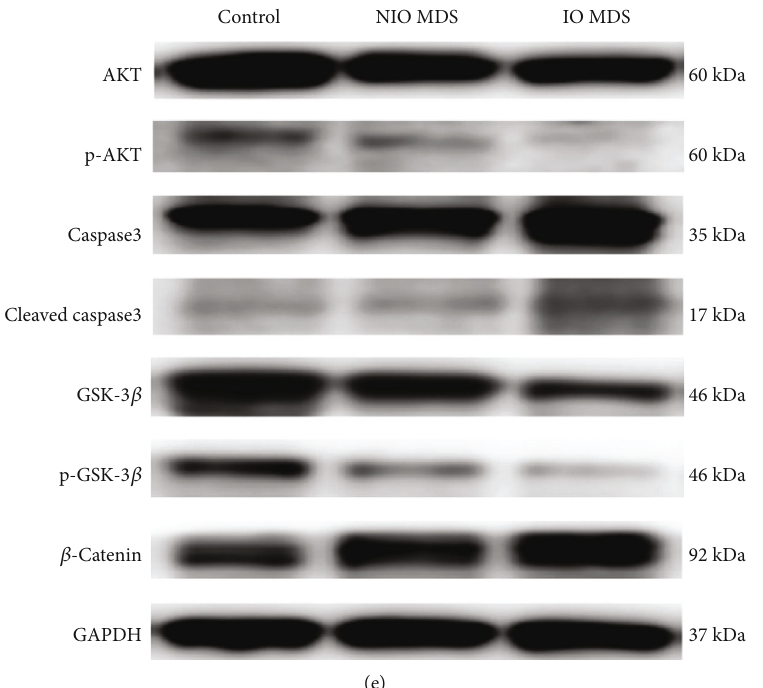
Figure 2: The mechanisms involved in IO damaging MSCs of MDS patients. (a) Compared with the NIO MDS group and the control group, the apoptosis of MSCs signi fi cantly increased in the IO MDS group ( p < 0 : 01 ). (b) Compared with the other groups, the level of ROS signi fi cantly increased in MSCs of the IO MDS group ( p < 0 : 01 ). (c – d) The gene expressions of caspase3 and β -catenin were signi fi cantly upregulated in MSCs of the IO MDS group compared with those of the other groups. (e) The protein of p-AKT in IO MDS MSCs was downregulated, while caspase3 was upregulated. The protein of β -catenin in IO MDS MSCs was upregulated, while GSK-3 β was downregulated. Compared with the control group: ∗ indicates p < 0 : 05 ; ∗∗ indicates p < 0 : 01 ; ∗∗∗ indicates p < 0 : 001 . Compared with the NIO MDS group: # indicates p < 0 : 05 ; ## indicates p < 0 : 01 (Figure 1(e) A – C). The level of TGF- β 1 in the culture super-